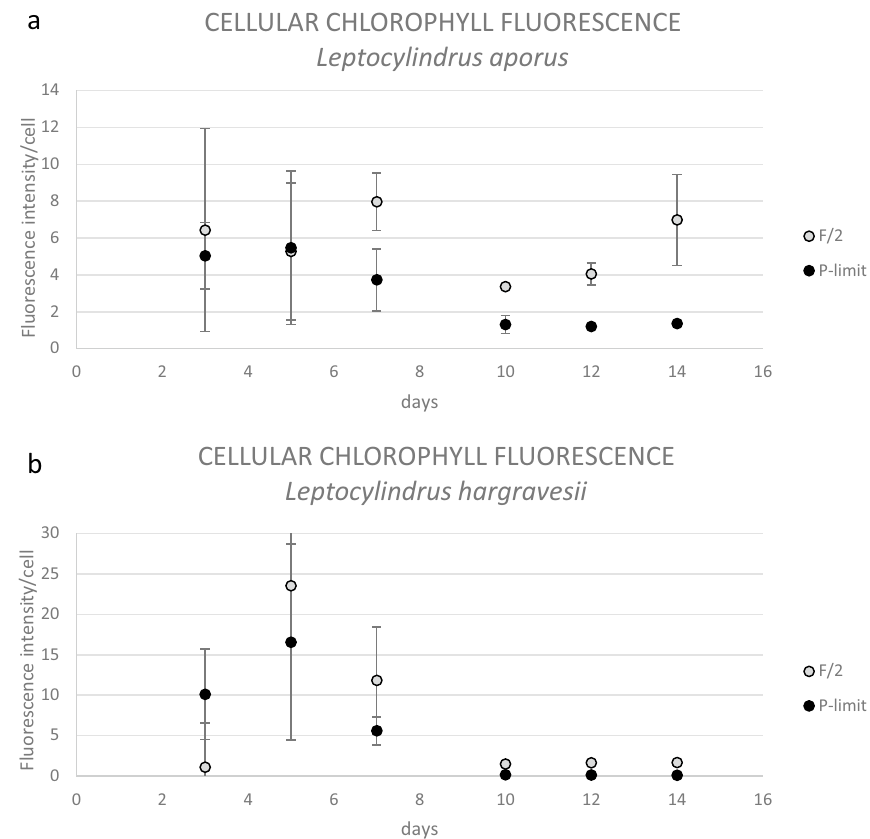
Figure 11. Fluorescence intensity/cell between F/2 and P-limited medium for both investigated species, L. aporus ( a ) and L. hargravesii ( b ).